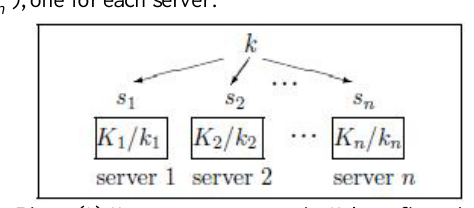
Figure (1): Key management service K/k configuration